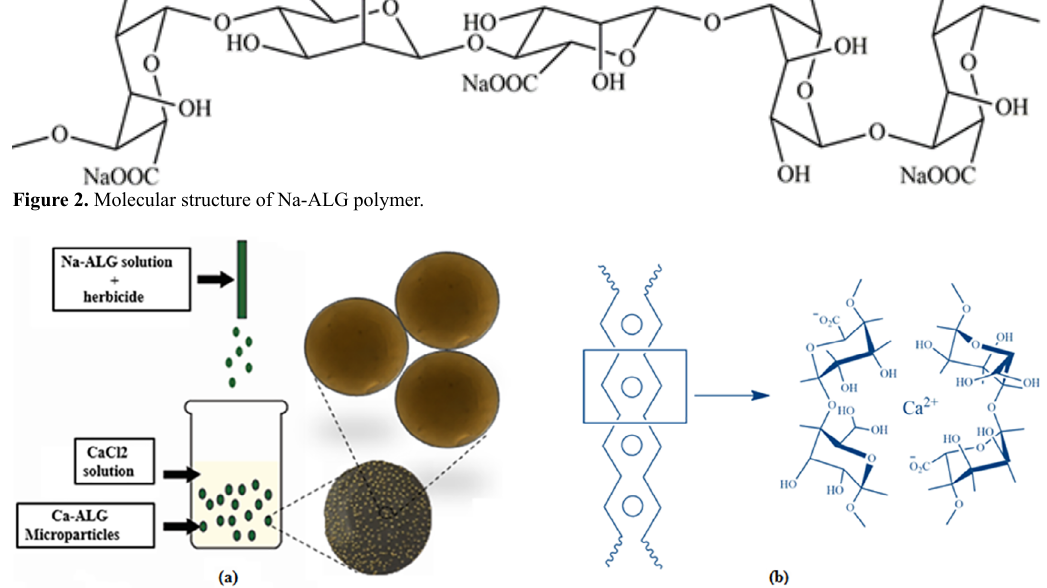
Figure 3. (a) Schematic drawing of the production of Ca-ALG microparticles containing the herbicide Sulfentrazone by ionotropic gelation method and (b) alginate hydrogels prepared by ionic cross-linking (egg-box